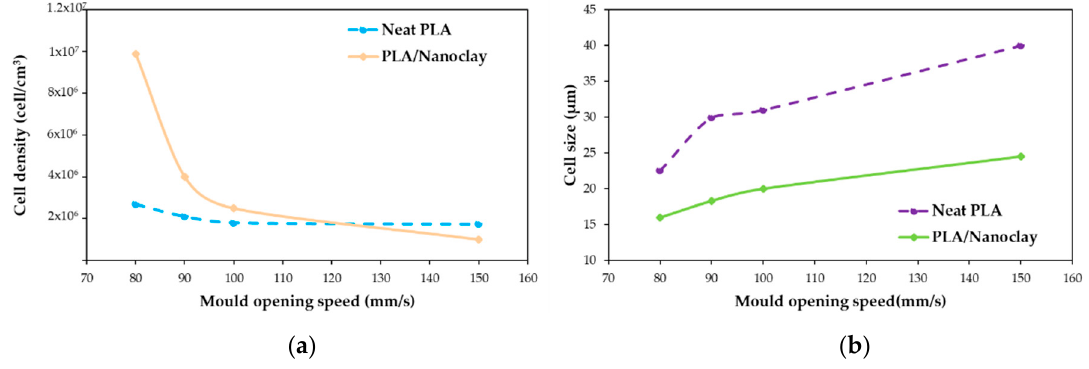
Figure 20. ( a ) Cell density and ( b ) cell size of foams obtained at different mold opening rates for neat PLA and PLA/nanoclays. Data taken from Xie et al. [136]. PLA and PLA / nanoclays. Data taken from Xie et al.